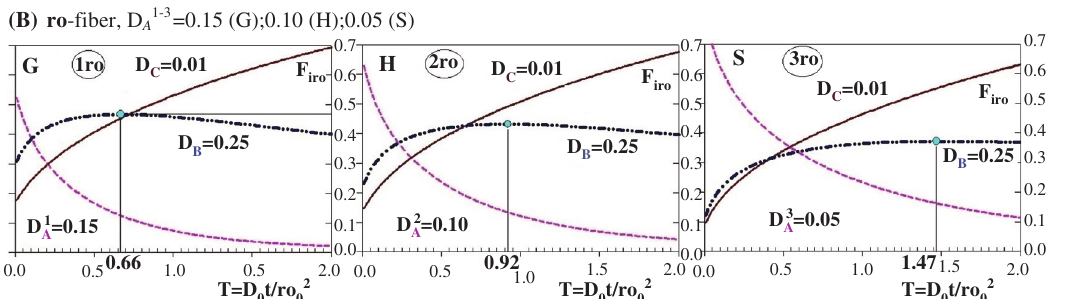
(T) curve behavior: r -bead ( a , 1r-3r), T 2 r , ro